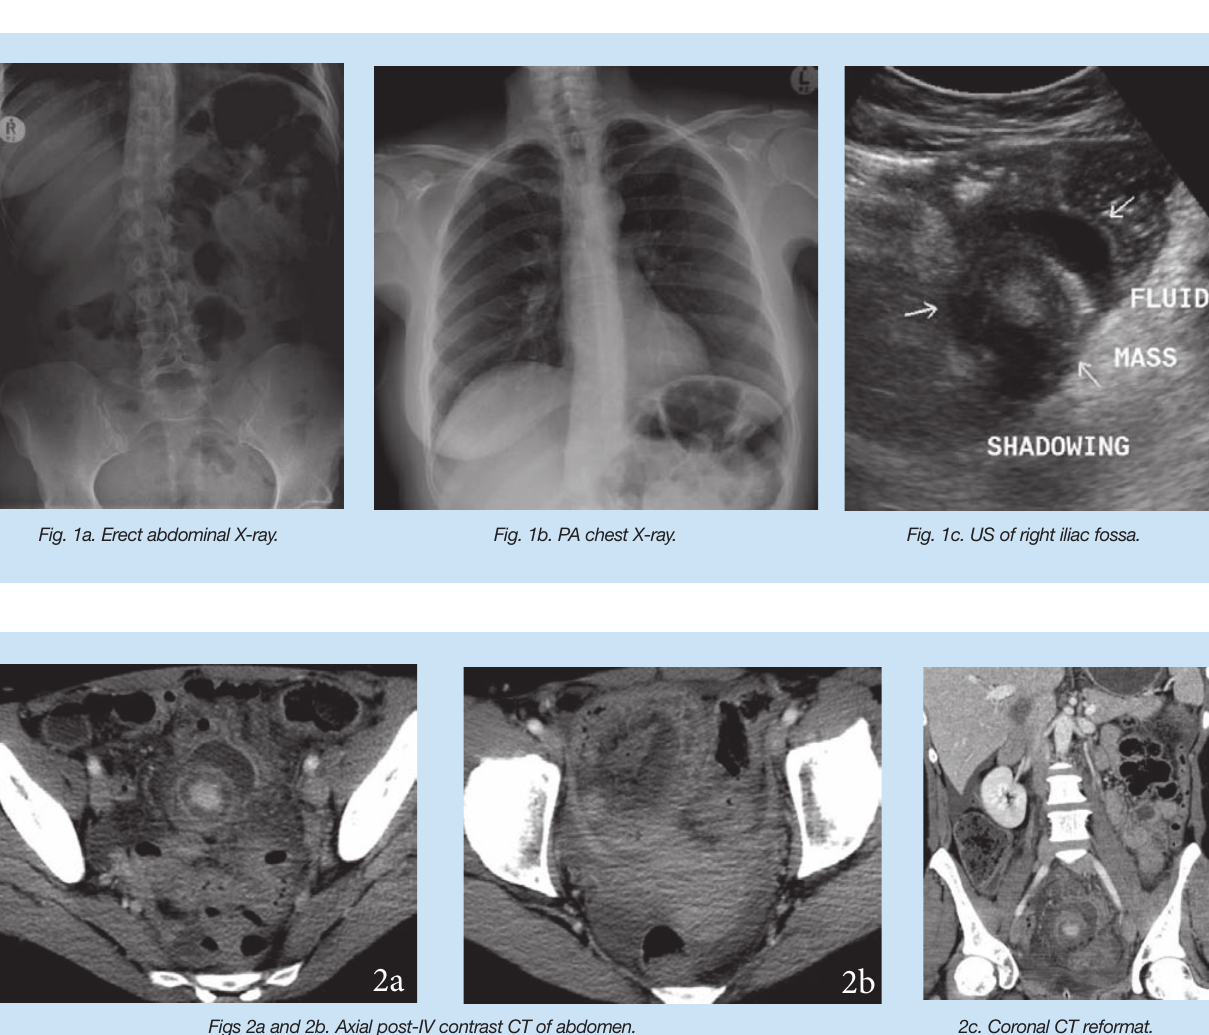
Figs 2a and 2b. Axial post-IV contrast CT of abdomen. 2c. Coronal CT